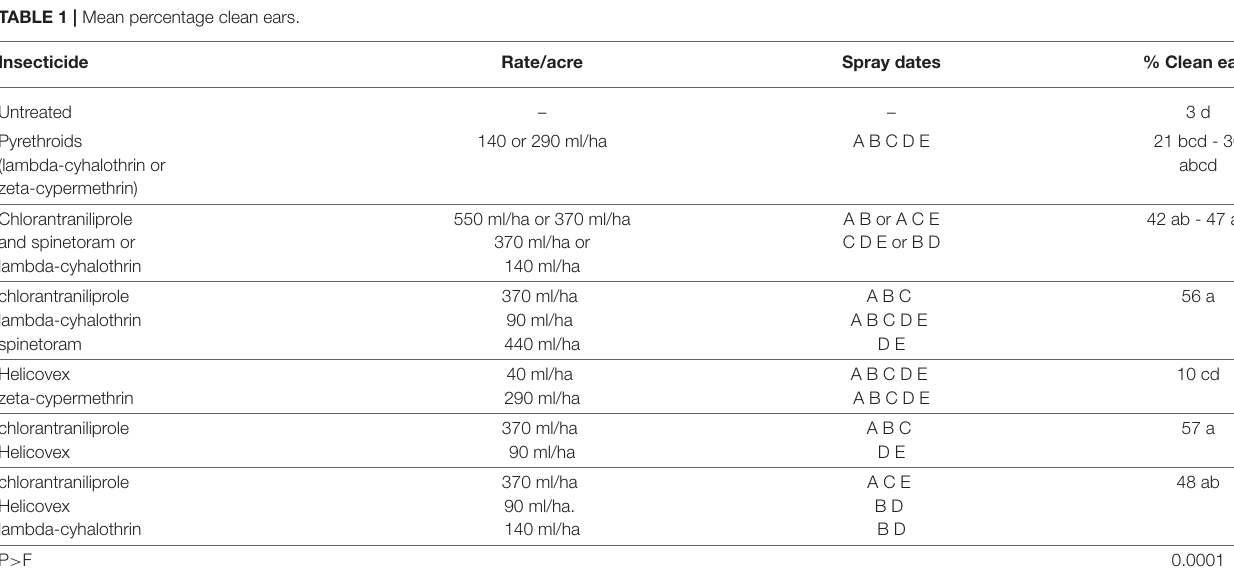
TABLE 1 | Mean percentage clean